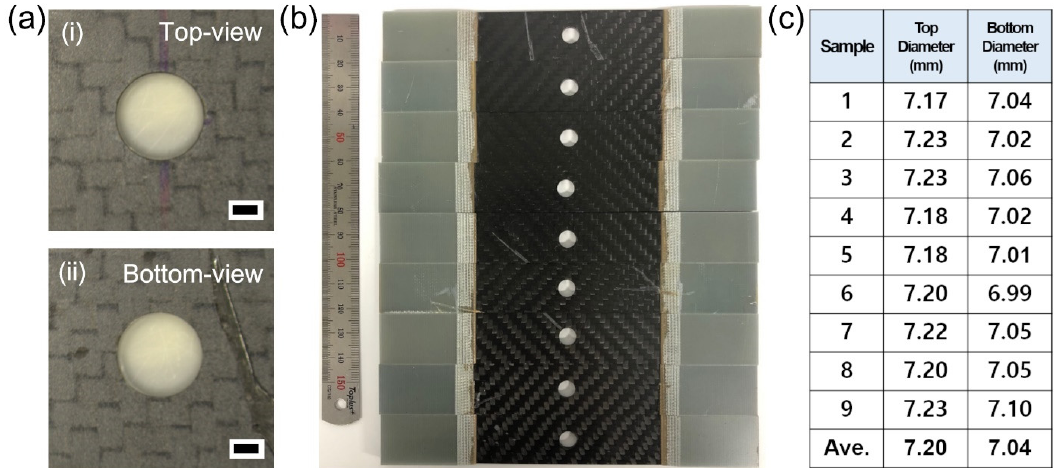
Figure 11. Laser-drilled hole diameters of the thermoset CFRP. ( a ) Stereoscopic microscope images of laser-drilled hole with (i) top view and (ii) bottom view. Each scale bar = 2 mm. ( b ) Photograph of laser-drilled specimens for tensile strength tests. ( c ) Systematic investigation of hole diameters of top and bottom sides as shown in ( b ). Average values of the diameters are 7.2 and 7.04 mm for the top and bottom sides.